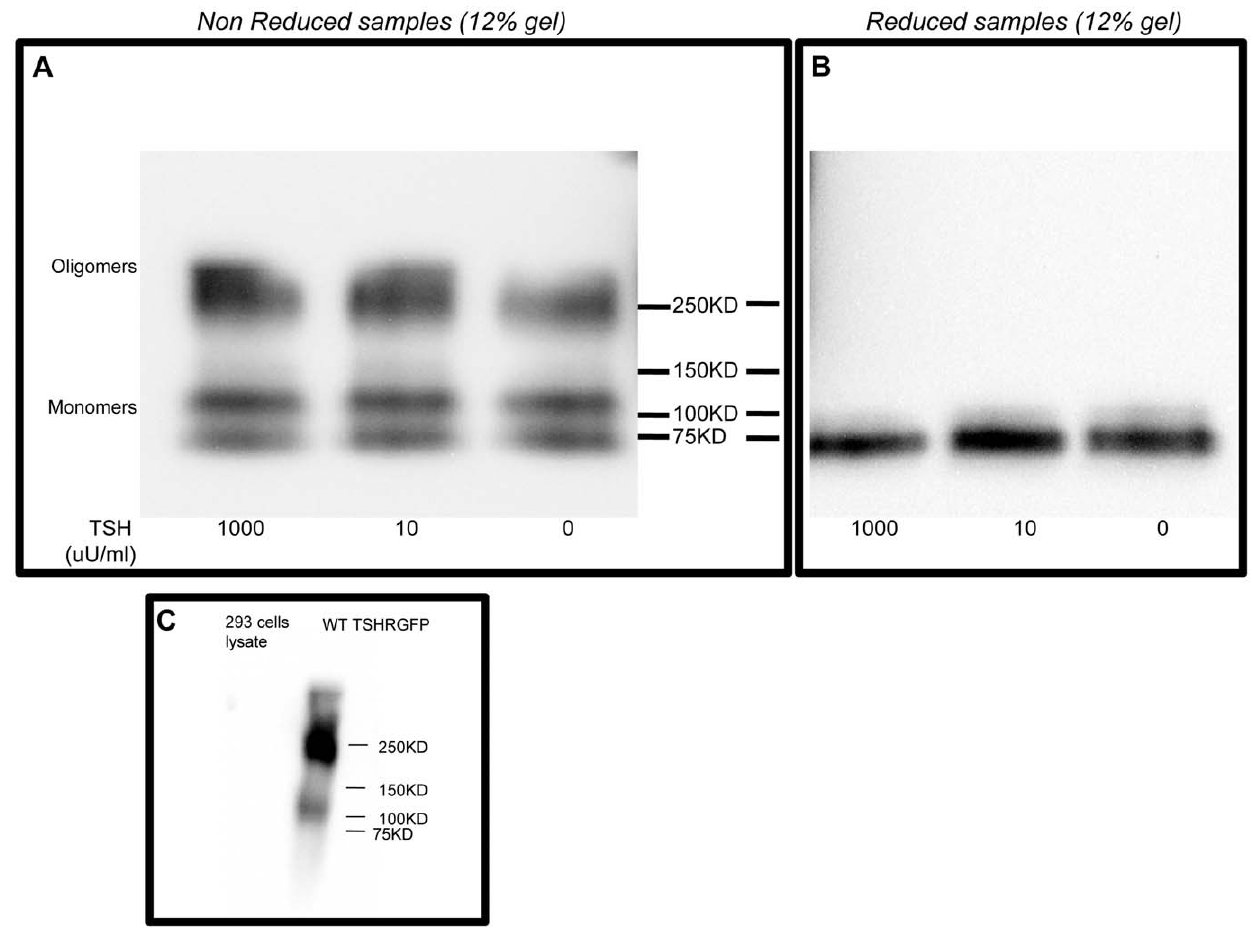
Figure 2. Immunoblot of total membranes under reduced and non-reduced conditions from stably transfected cells: CHO cells stably expressing GPI-TSHR-ecd were treated with 0, 10 and 1000 m U/ml of bovine TSH for 1 hr at 37 u C. Membranes prepared from untreated and treated cells was divided into 30 ug/lane and treated with 5X sample buffer containing reducing agent ( + DTT: 100 mM final) and non-reducing agent (-DTT) and separated on a 12% SDS-PAGE. Proteins were transferred onto PVDF and probed by 2 ug/ml TSHR antibody M4 (epitope 322–341) followed by detection with anti-mouse HRP (1:20,000) and developed using pico SuperSignal ECL (Pierce Ltd). Panel A ) Shows the non-reduced untreated and treated samples. Oligomeric forms of 200–250 KD were observed in addition to the mature 100KD and less mature 75 KD monomeric forms GPI linked TSHRs. Panel B ) Untreated and treated samples after reduction with DTT for 45 minutes at 50 u C showing no higher order forms of the TSHR- ecd indicating the instability of the TSHR-ecd higher order forms. This is a representative blot from two experiments performed under identical conditions. Panel C ) the specificity of the antibody M4 used for immunoblotting throughout the study is indicated in this blot. Lysates from untransfected HEK 293 cells and TSHRGFP transfected wild type cells were resolved on SDS-PAGE and immunblotted with 2 ug/ml of M4 antibody. M4 did not have any reactivity with untransfected lysate as opposed to TSHR transfected lysate where it detected the monomeric and multimeric forms of the